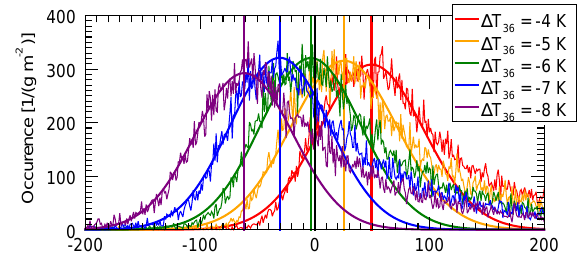
Figure 1. Example of histograms of retrieved LWP and fitted Gaus- sian for different bias correction values at 36GHz. The example shows MWR on Envisat, January 2005. For the example shown here, the bias correction at 23GHz is set to − 3K.